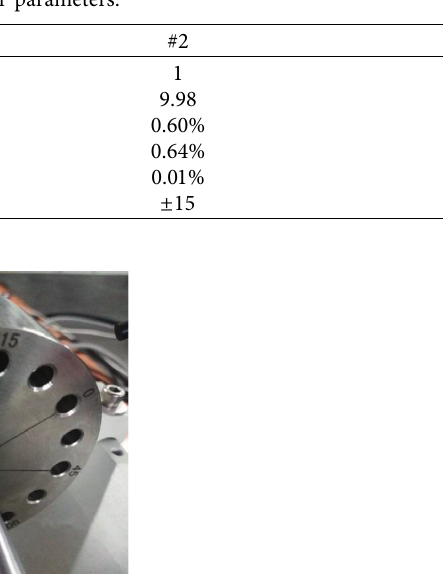
Figure 4: Disc with holes for mounting correction